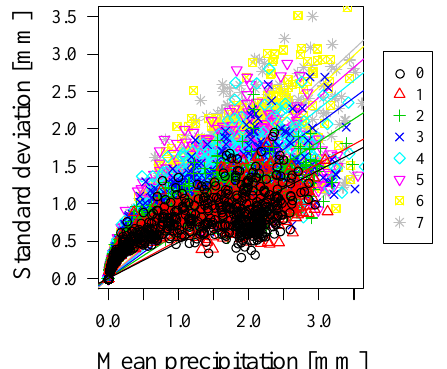
Fig. 12. Sensitivity analysis. Scatter plot ˆ µ J,t and ˆ σ J,t lumped over time with fitted coefficients of variations (CV J ) for the rainfall sce- nario with an advection speed of 6kmh − 1 (see Fig. 5) and a catch- ment area of 4900km 2 . Different points in the panel are for individ- ual points (pixels) of the catchment.